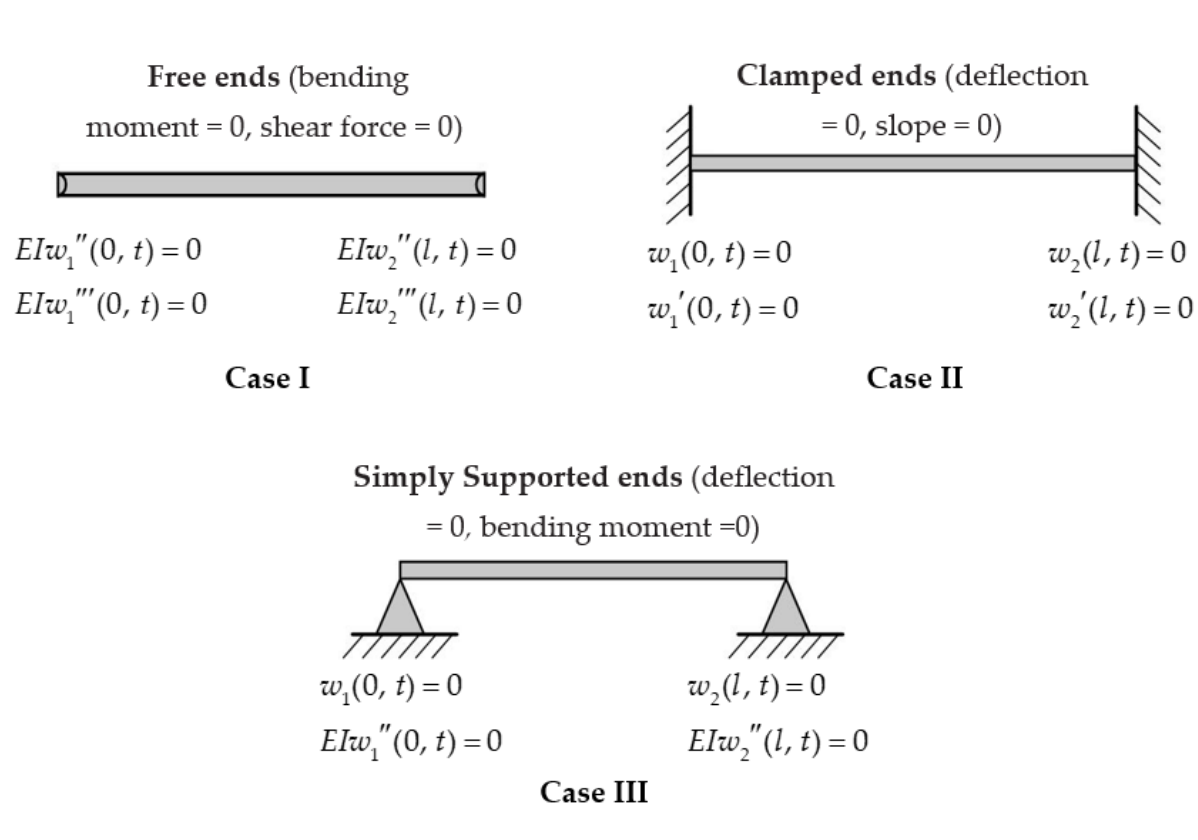
Figure 2. Geometry of prismatic cantilever beam.